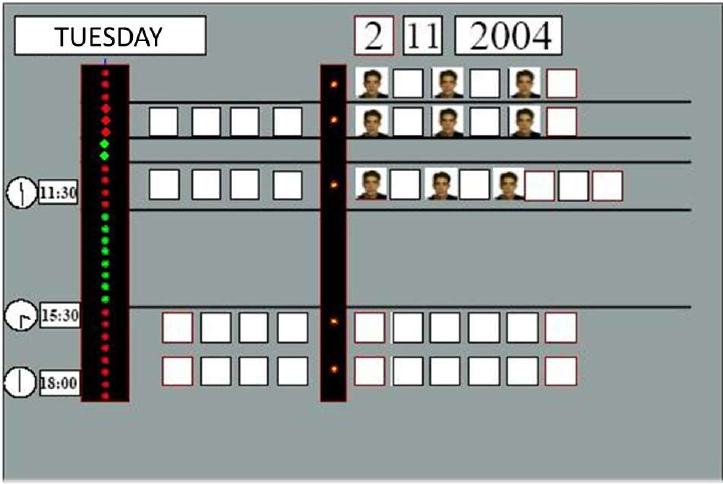
Figure 1. First adaptation of TOD to blackboard agenda.